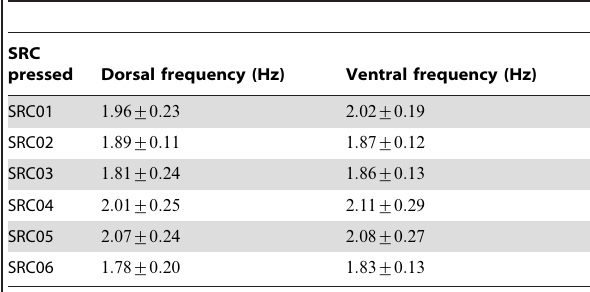
Table 1. Mean frequency of the CPG rhythm during routine